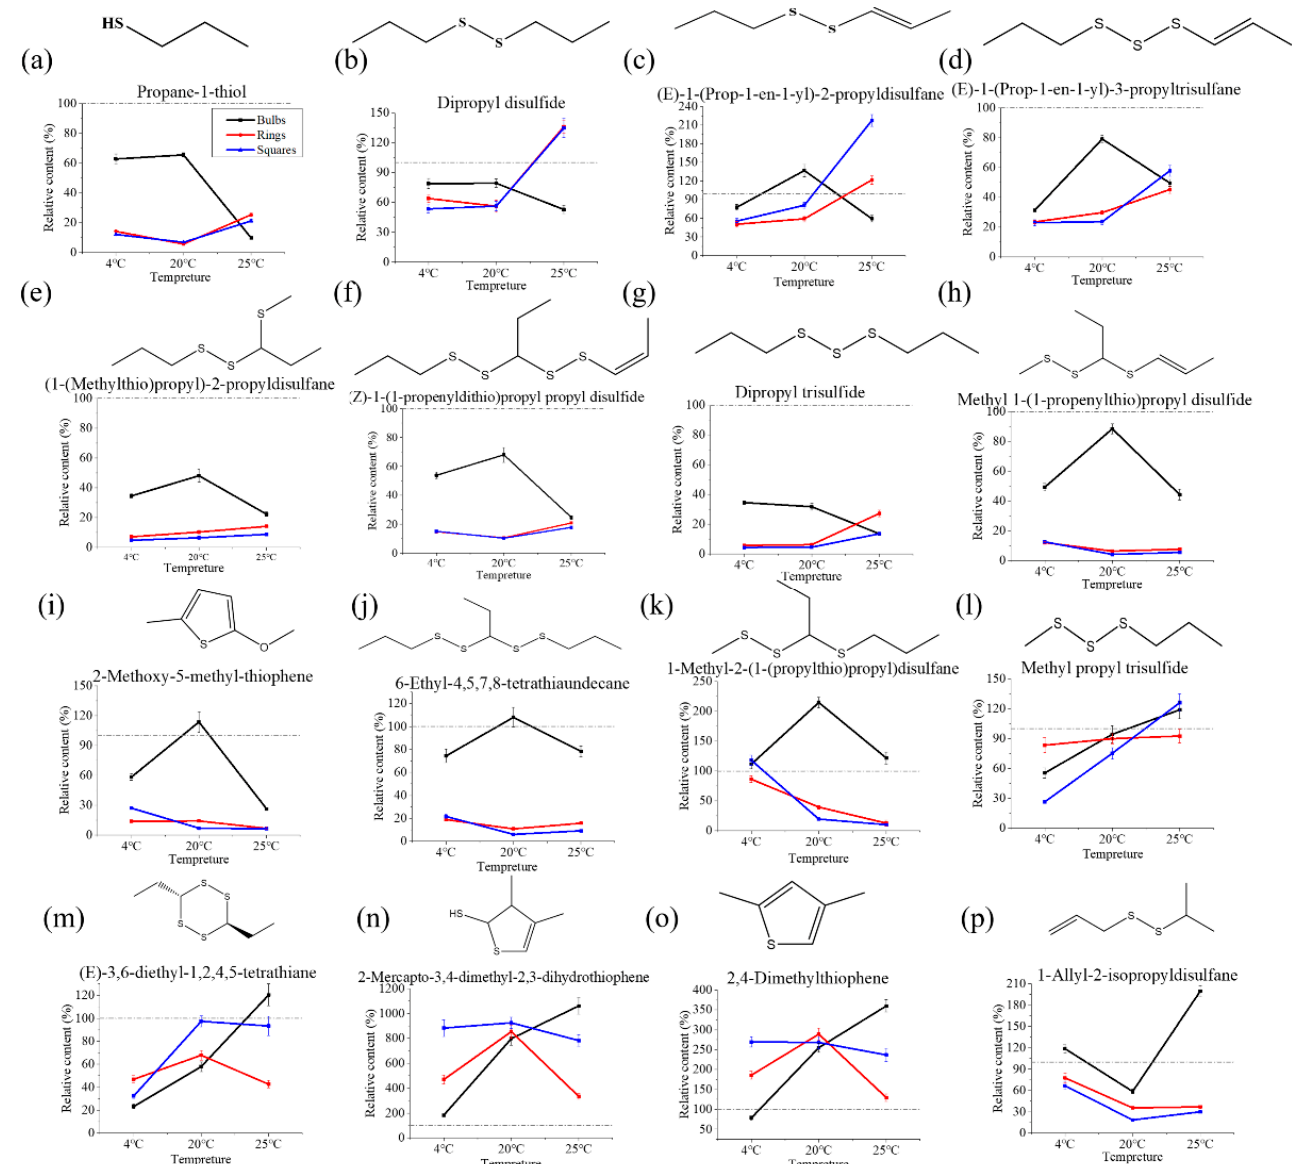
Figure 4. Concentration changes of 16 volatile sulfur compounds in onions with different fresh-cut styles and different storage temperatures. ( a – p ), the structure and relative contents of propane-1-thiol, dipropyl disulfide, ( E )-1-(prop-1-en-1-yl)-2-propyldisulfane, ( E )-1-(prop-1-en-1-yl)-3-propyltrisulfane, 1-(methylthio)propyl)-2-propyldisulfane, ( Z )-1-(1-propenyldithio)propyl propyl disulfide, dipropyl trisulfide, methyl 1-(1-propenylthio)propyl disulfide, 2-methoxy-5-methyl-thiophene, 6-ethyl-4,5,7,8- tetrathiaundecane, 1-methyl-2-(1-(propylthio)propyl)disulfane, methyl propyl trisulfide, ( E )-3,6- diethyl-1,2,4,5-tetrathiane, 2-mercapto-3,4-dimethyl-2,3-dihydrothiophene, 2,4-dimethylthiophene, 1-allyl-2-isopropyldisulfane the relative contents of, respectively. The grey dotted line was the relative value of the control groups (100).